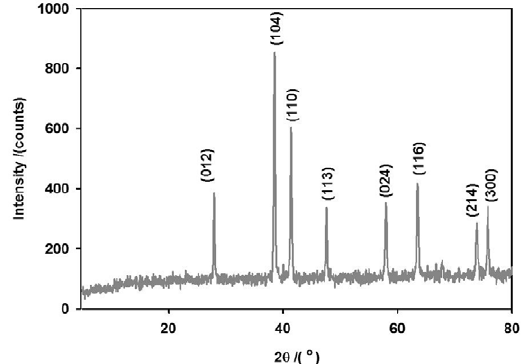
Fig.3. FESEM image of iron oxide nanoparticles prepared by sol-gel auto-combustion with ultrasonic